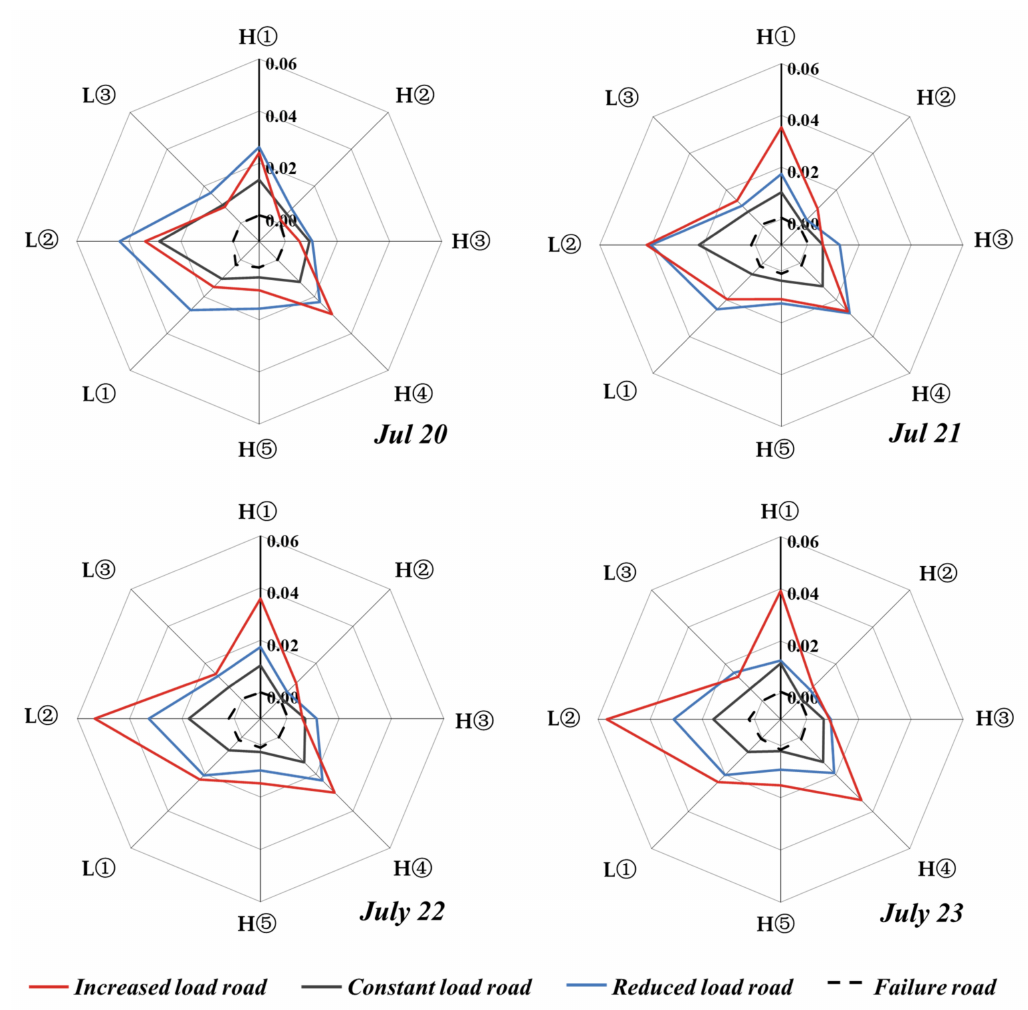
Figure 10. The road segment ratio with increased/reduced/constant loads in different vulnerability hot or cold